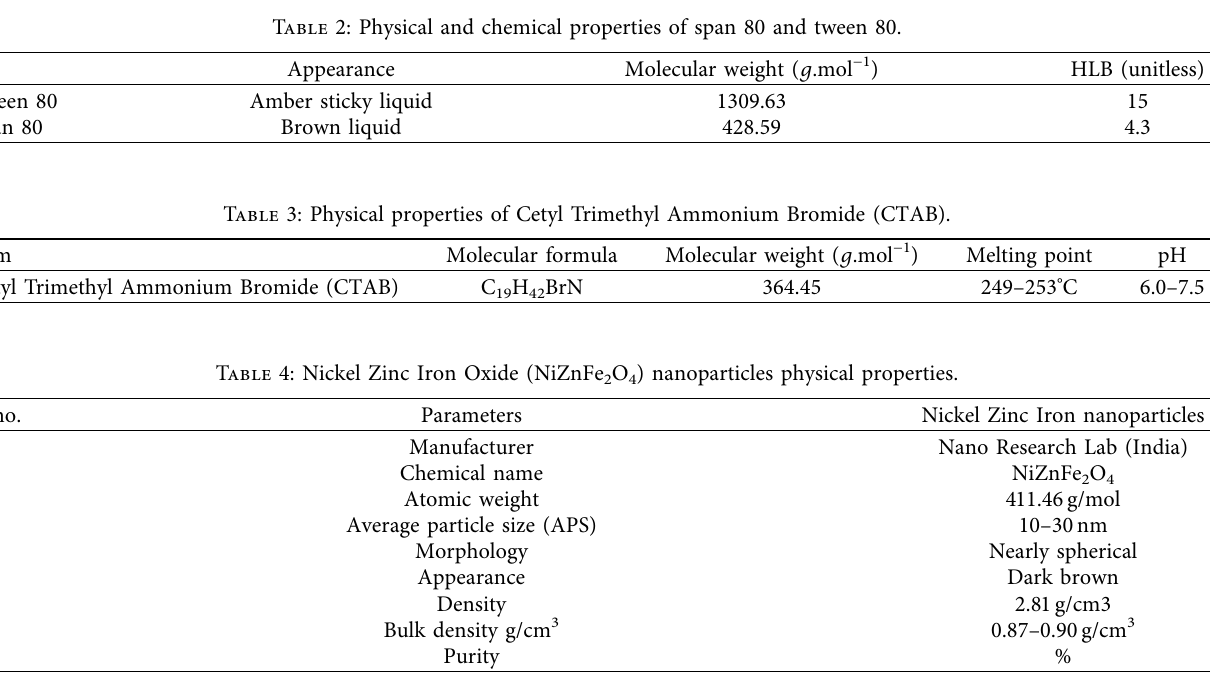
Table 7. The first step is the same for all the fuels.